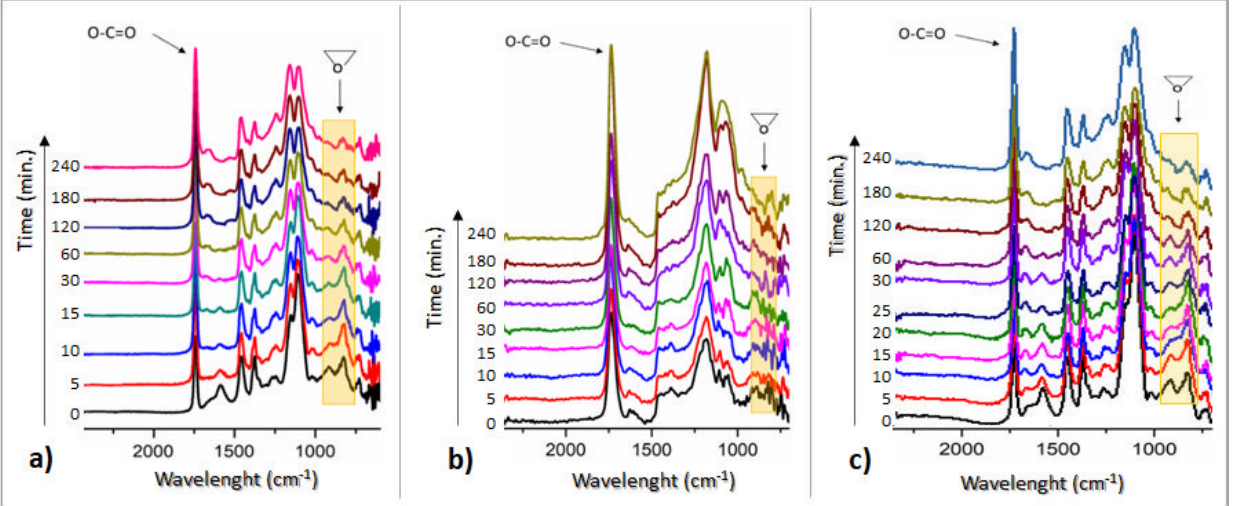
Figure 3. FTIR spectra from the curing kinetics of the ELO ‐ based systems at different reaction times: ( a ) ELO_CA_W at 80 °C, ( b ) ELO_CA_THF at 80 °C, ( c ) ELO_D at 130 °C.